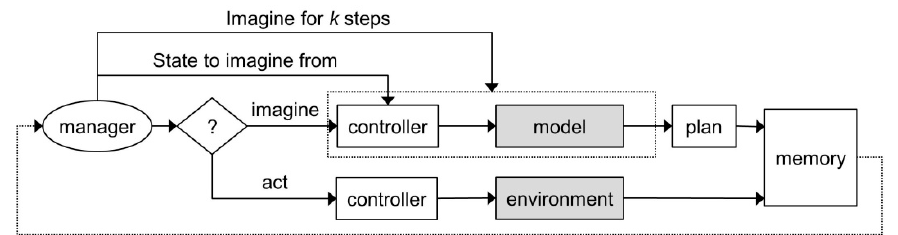
Figure 9. High level view of the Imagination-Based Planner (IBP). The manager chooses whether to act or imagine. When acting, the controller performs an action on the environment, whereas when imagining, the controller proposes an imagined action which is evaluated via a model of the world (imagination). The resulting data is aggregated in the memory.